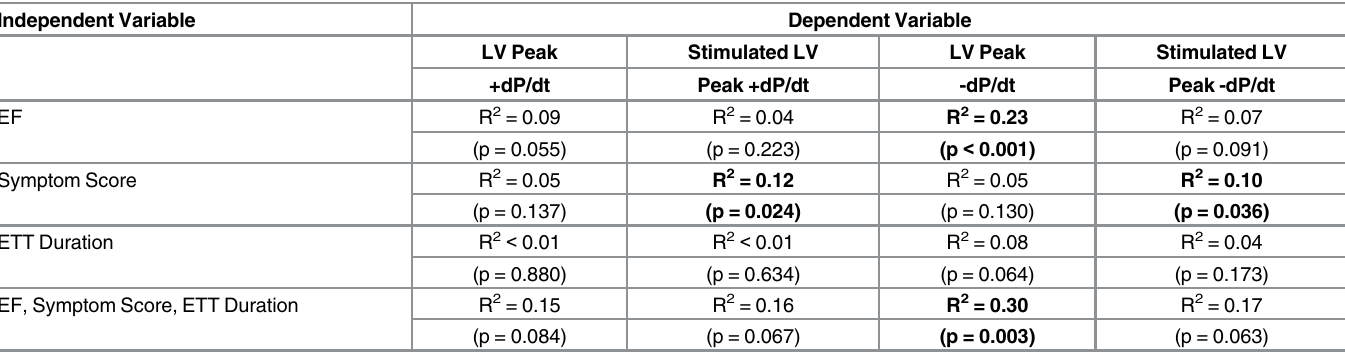
Table 4. Linear Regressions Among Markers of Heart Function.